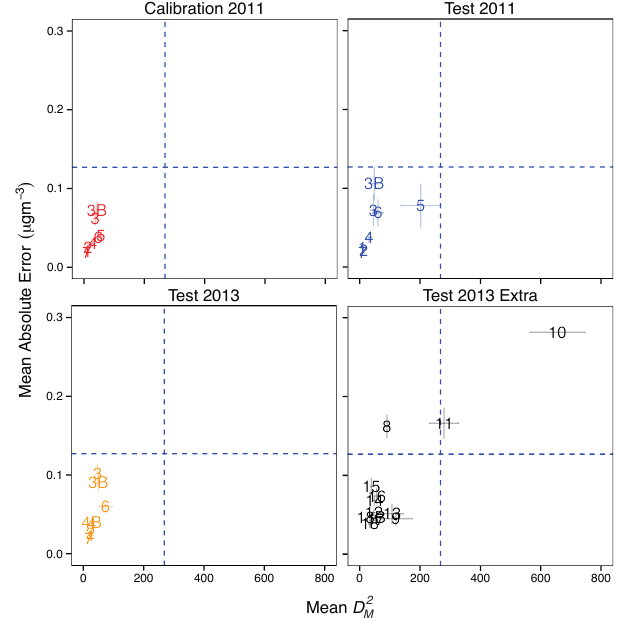
Figure 11. FT-IR EC. Anticipation of the prediction error. Mean squared Mahalanobis distance (between the scores of each data set described in Sect. 2.1 and the centroid of the calibration data set) against mean absolute error (between TOR OC and FT-IR OC). The measurements are aggregated per site. Each site is denoted with the site ID used in Table